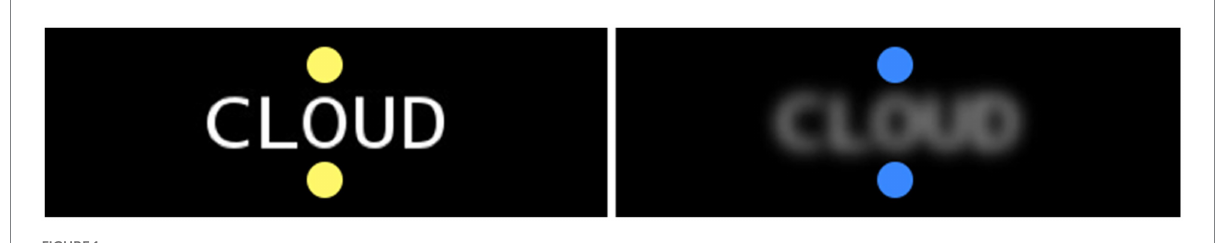
FIGURE 1 An example of a clear and blurry word, including target and distractor coloured dots, used in each of the four